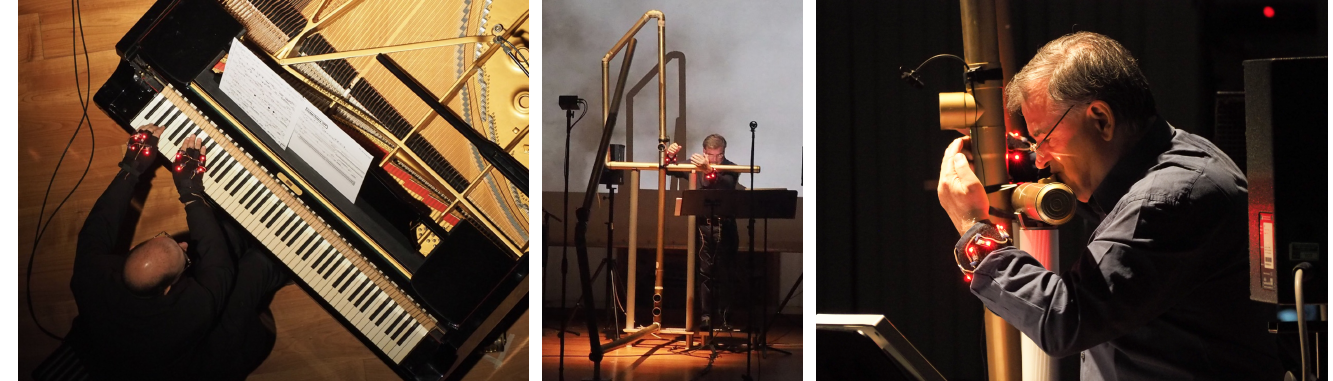
Figure 25. Chemical free (?) by Nicola Sani. Position sensors are applied to the wrist of the pianist (Aldo Orvieto) and the hyperbass flutist (Roberto Fabbriciani) to control the performance